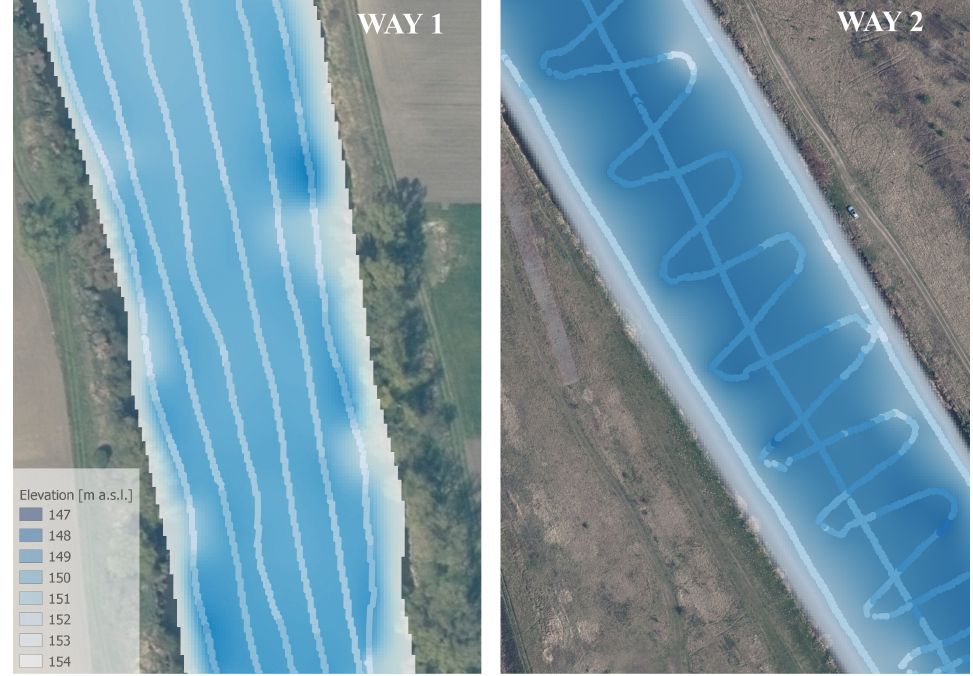
Figure 4. Comparison of two navigation ways: Way 1: parallel lines and Way 2: parallel lines and